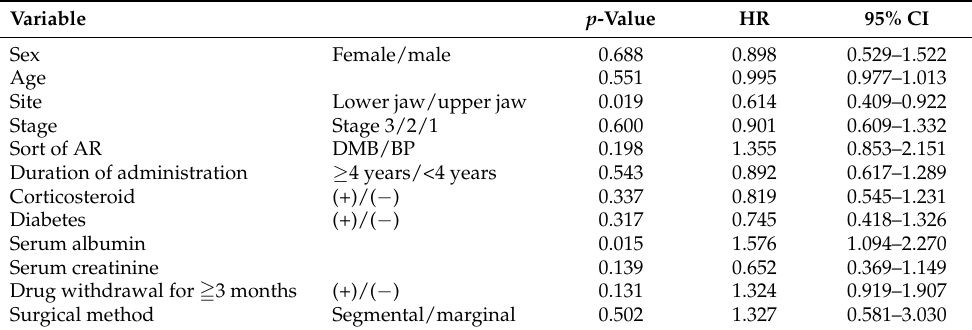
Table 4. Factors related to healing rate of MRONJ by univariate analysis of 139 patients undergoing surgical